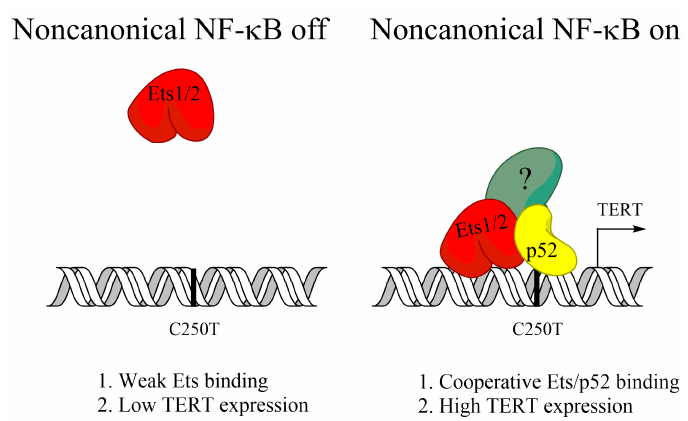
Figure 2. Cooperation of Ets and p52 in promoting TERT expression when promoter is mutated. The C250T mutation in the TERT promoter creates a p52 binding site. When noncanonical NF- κ B is activated in C250T mutant cells, p52 can recruit Ets transcription factors to the mutated TERT promoter and drive transcription.